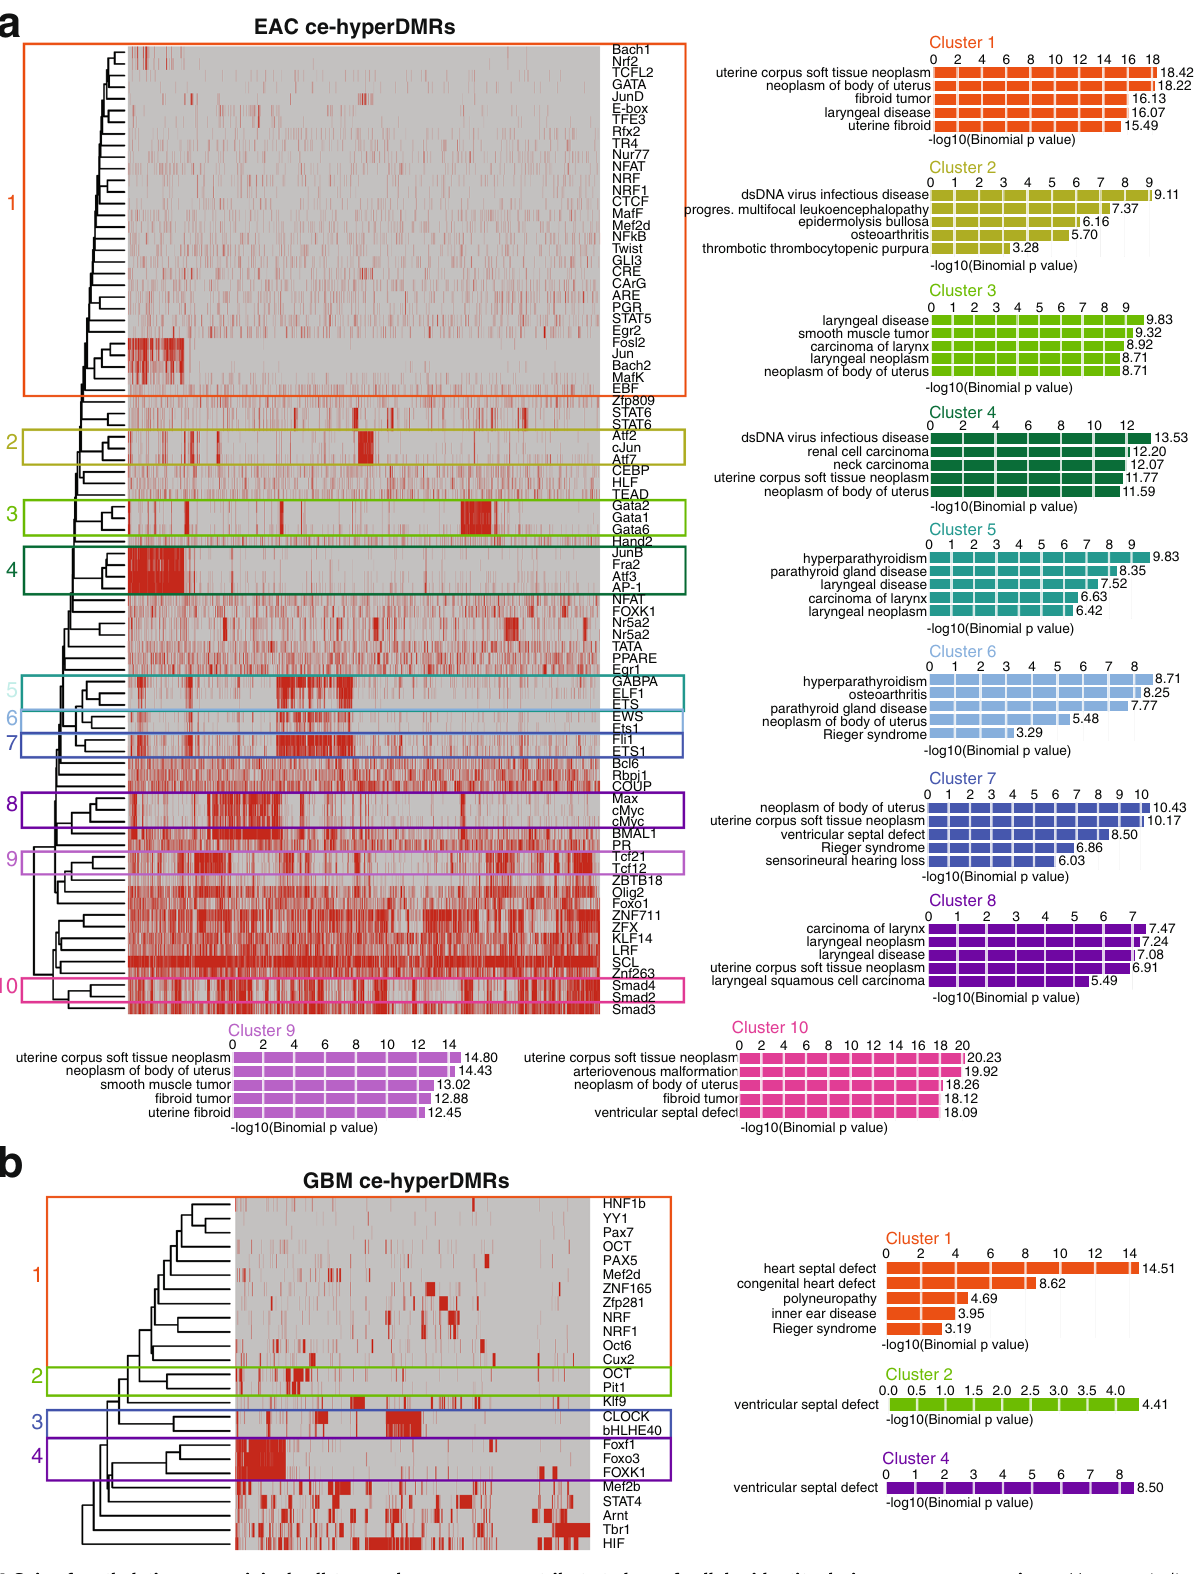
Fig. 4 Gain of methylation over original cell-type enhancers may contribute to loss of cellular identity during cancer progression. a Heatmap indicating the presence of enriched TF-binding motifs in EAC ce-hyperDMRs and top GO disease ontology enrichment results for DMR clusters (red: present; gray: absent). b Heatmap indicating the presence of enriched TF-binding motifs in GBM ce-hyperDMRs and top GO disease ontology enrichment result for DMR clusters (red: present; gray: